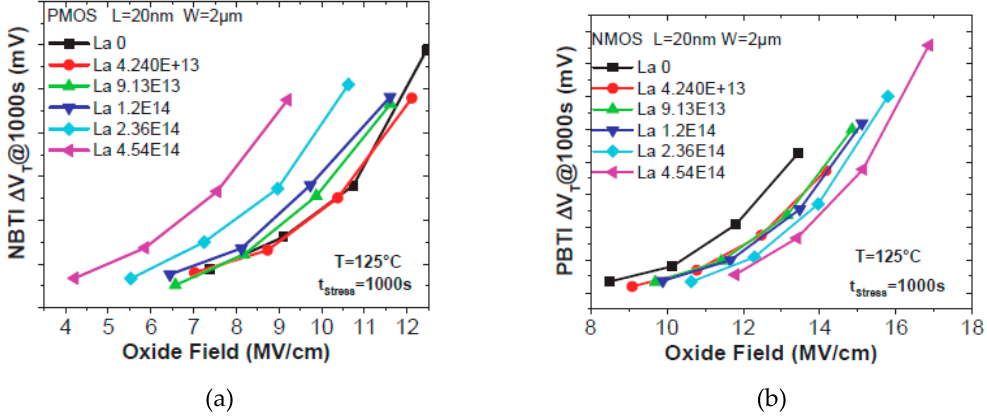
Figure 26. ( a ) NBTI V T shift vs. Eox after 1000 s for all e ff ective La doses in PMOS. La addition causes enhancement of NBTI V T degradation and ( b ) PBTI V T shift vs. Eox after 1000 s for all La doses for NMOS. La addition causes reduction of PBTI V T degradation